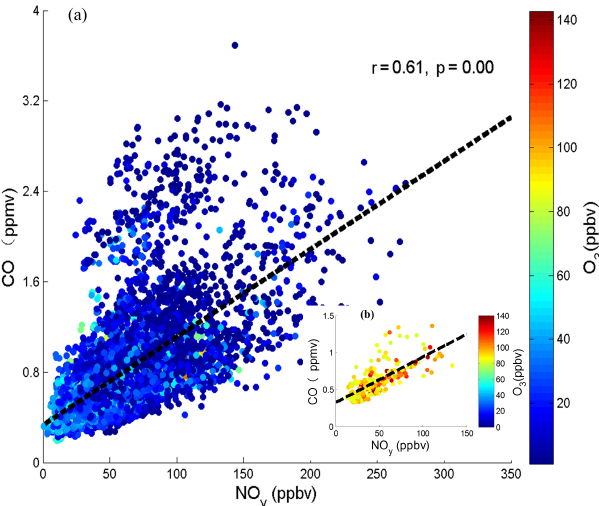
Figure 4. (a) Scatter plots of NO y with CO color-coded with O 3 mixing ratios are shown, as well as the inset (b) showing the scatter plot with O 3 mixing ratios above